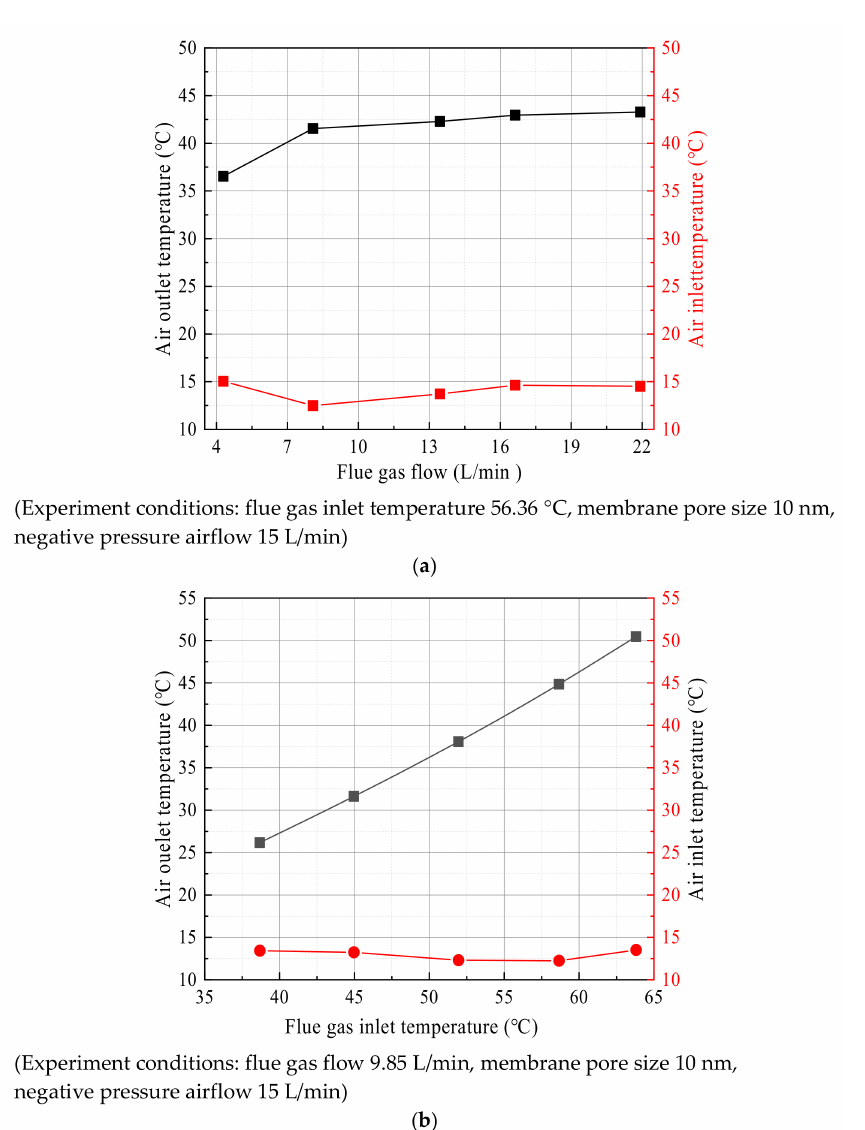
Figure 23. The inlet/outlet temperature of negative pressure air. ( a ) The temperature of negative pressure air vs. Flue gas flow. ( b ) The temperature of negative pressure air vs. flue gas inlet